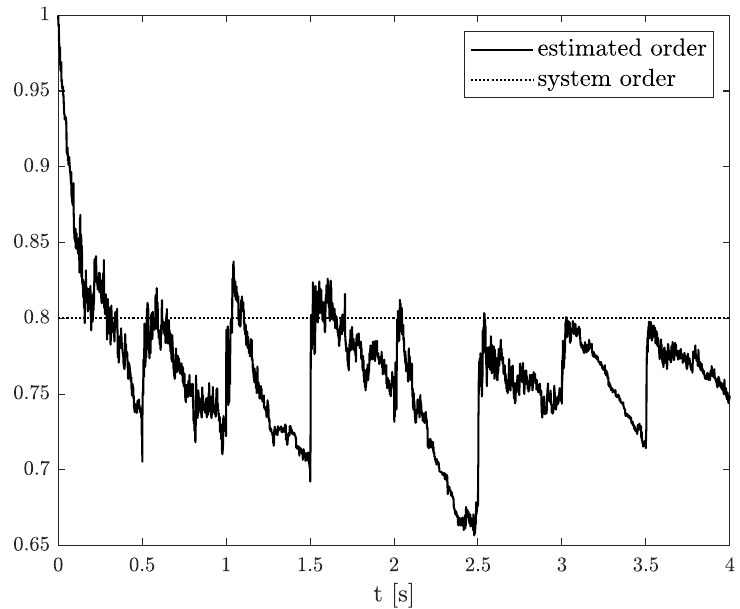
Figure 12. Original and estimated order from Example 3.